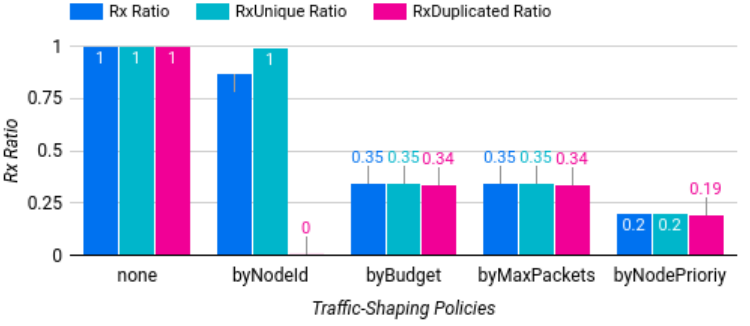
Figure 7. Summary of the baseline simulation results.